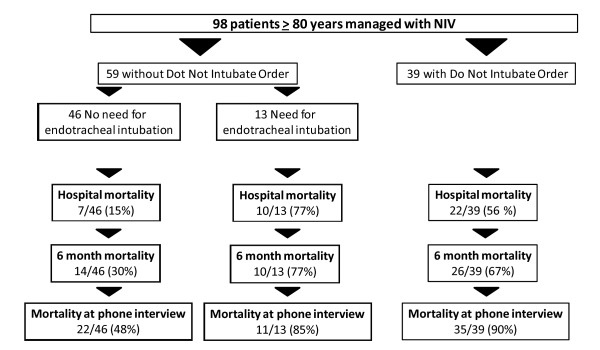
Outcome in very old patients according to the context and success of NIV.